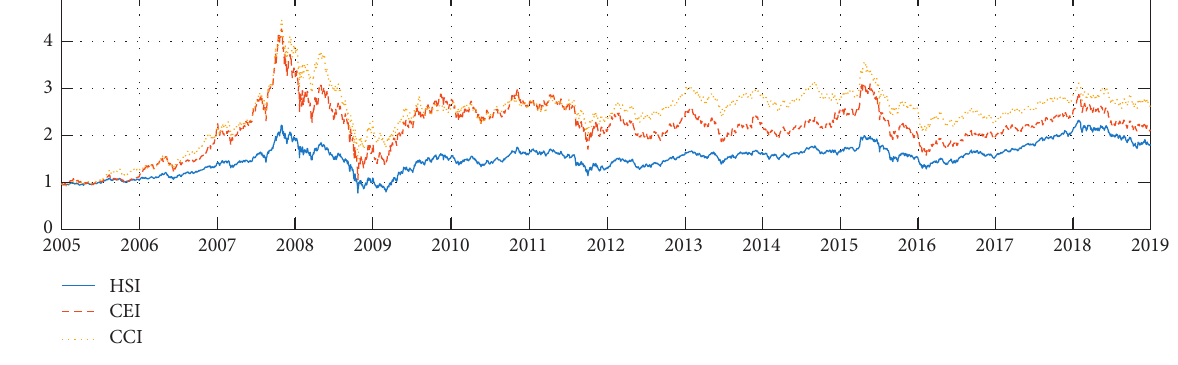
Figure 3: Relative price